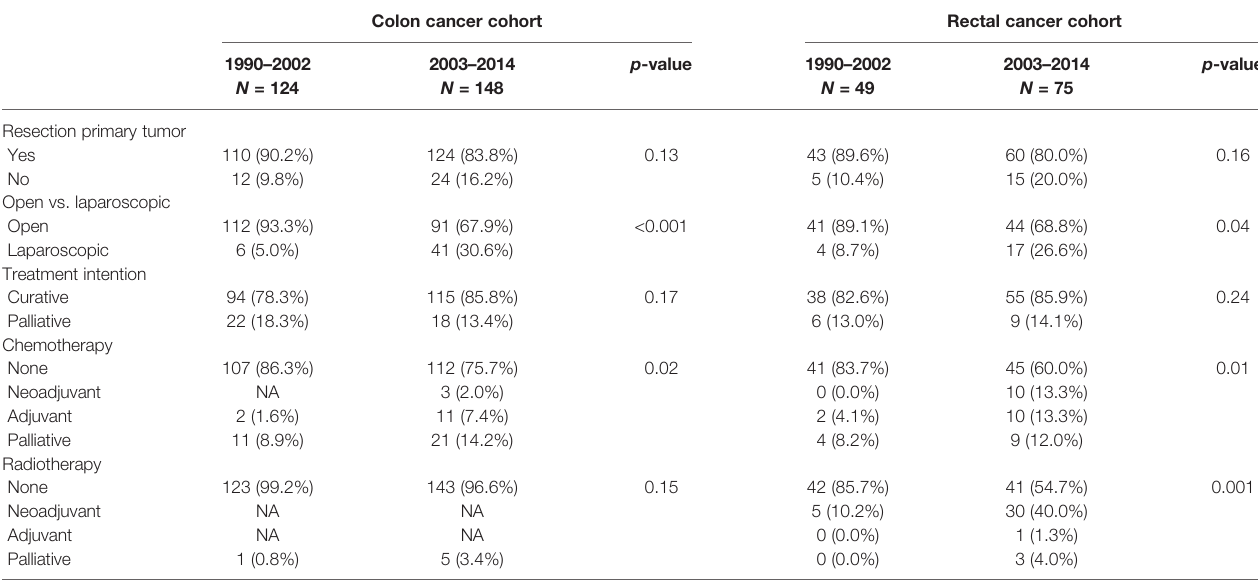
TABLE 3 | Treatment characteristics.